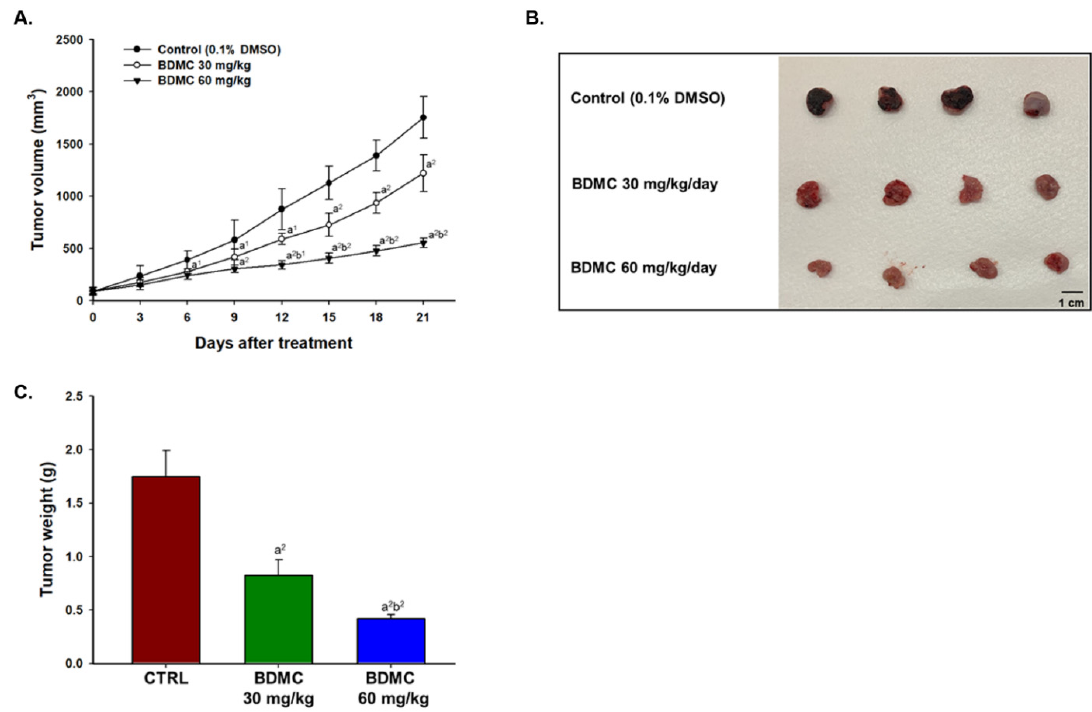
Figure 4. BDMC reduces GBM 8401/ luc2 cell xenograft tumor growth in athymic BALB/c nu/nu nude mice. After GBM 8401/ luc2 tumor-bearing mice were generated, mice were treated with DDW (0.1% DMSO) or BDMC (30 and 60 mg/kg) every three days. ( A ) The tumor volume of each mouse was measured every three days. ( B ) Images of representative mice tumors from each group. After mice were anesthetized with overdose isoflurane (>3%), they were sacrificed, and the final tumor weights were measured as described in the Materials and Methods. ( C ) Quantification results of mouse tumors weight from each group. a 1 and a 2 significantly differ at p < 0.05 and p < 0.01 vs. the control group. b 1 and b 2 significantly differ at p < 0.05 and p < 0.01 vs. the BDMC 30 mg/kg group. 2.5. BDMC Reduced Living Cell Signal of Nude Mice Bearing GBM 8401/luc2-Derived Tumors